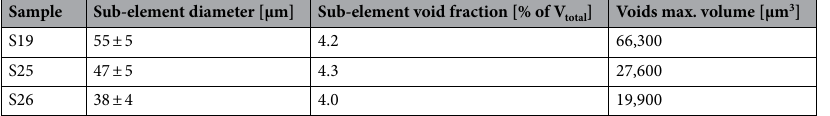
Table 2. Characteristics of the voids in the sub-elements for samples S19, S25 and S26.